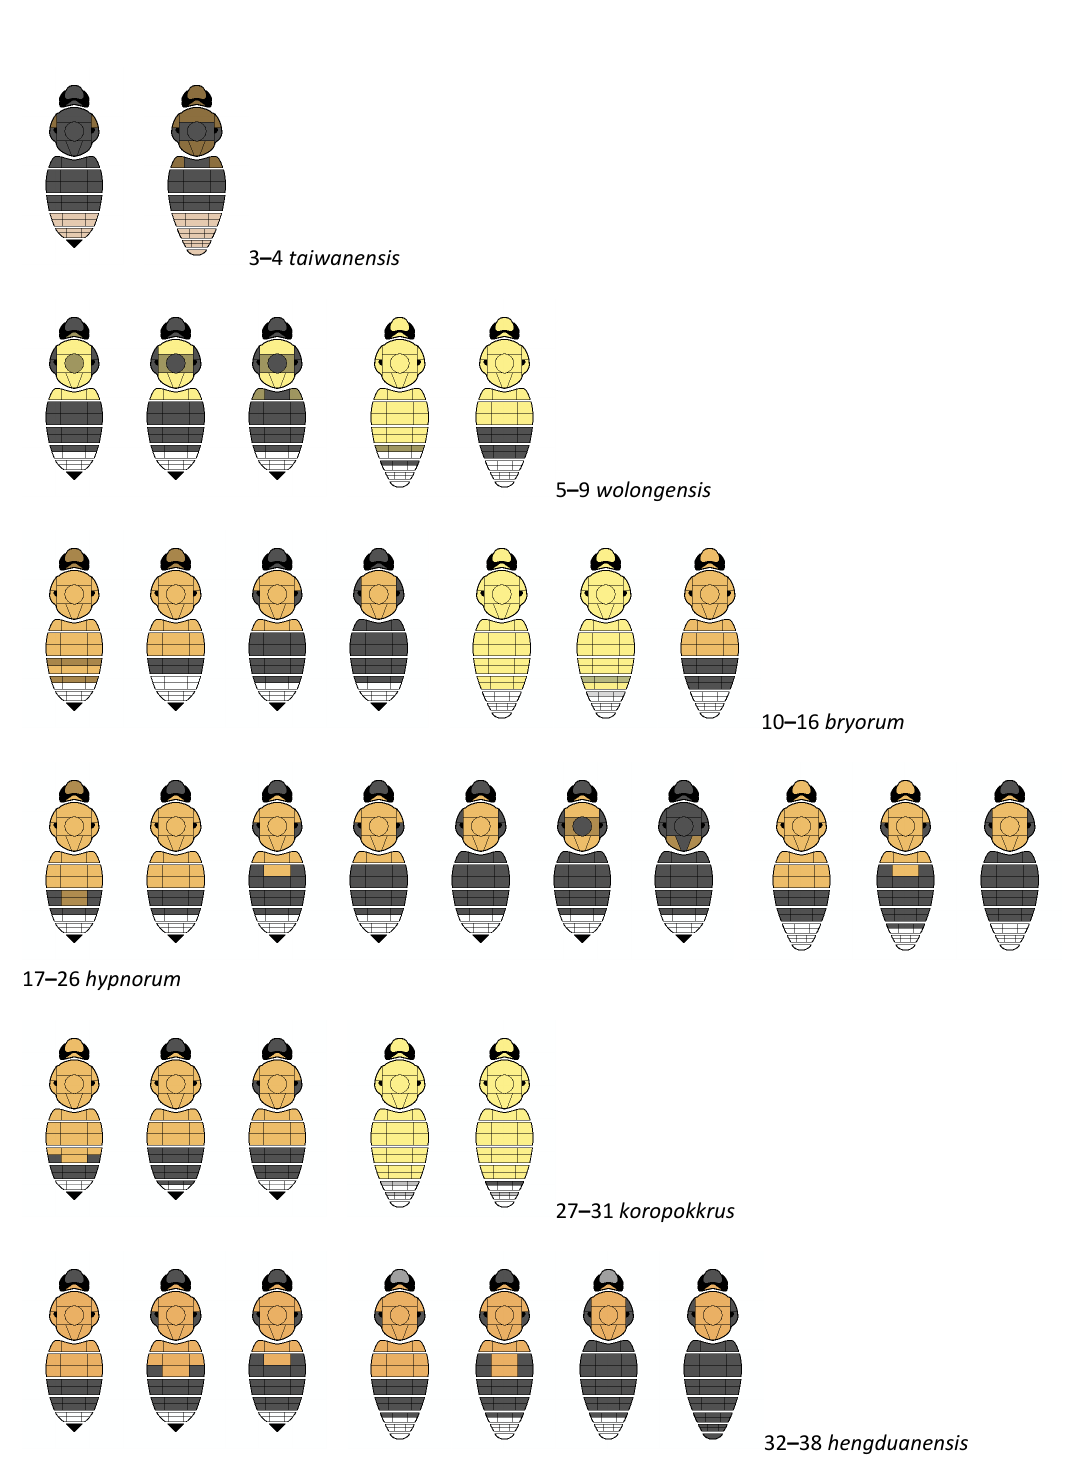
Figs 3–38. Simplified diagrams for the colour patterns of the hair on the dorsum for ♀♀ (left) and ♂♂ (right) of the Bombus species from Fig. 2. The dorsum is divided into regions, each of which shows only the predominant or most apparent colour for that region using a simplified colour palette (precise shades vary), with olive indicating a mixture of black and yellow hair, and grey indicating a mixture of black and white